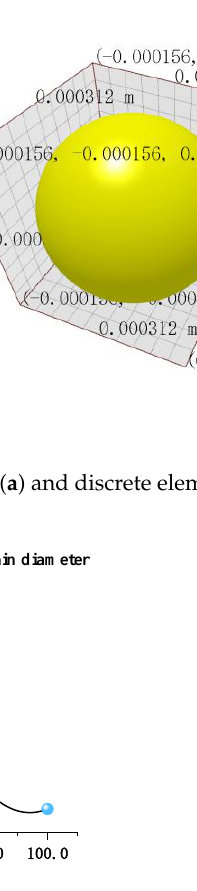
Figure 6. Tailings true particle size distribution map.